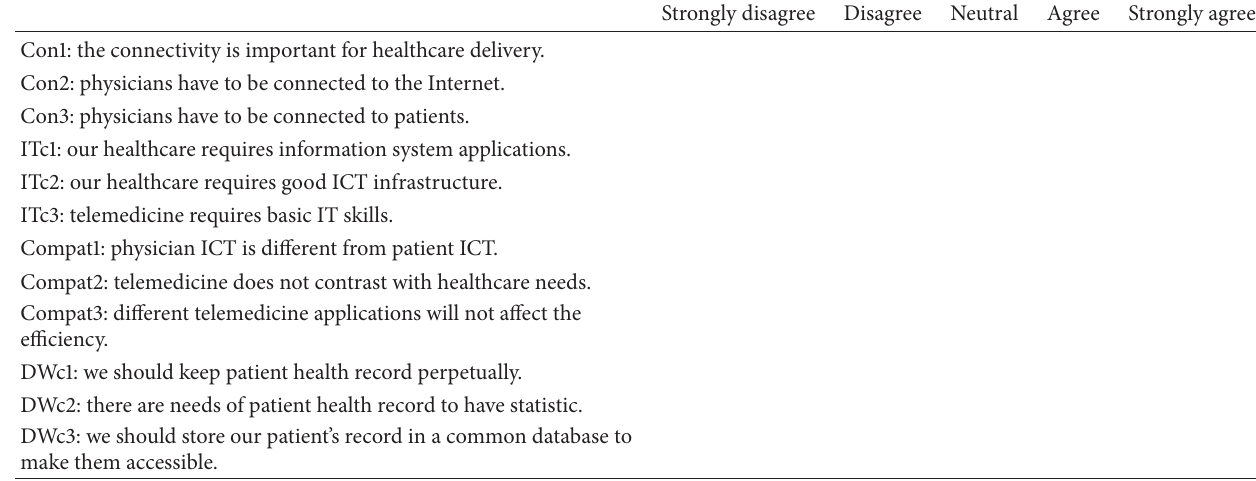
Table 6: Part 4: technological characteristic.